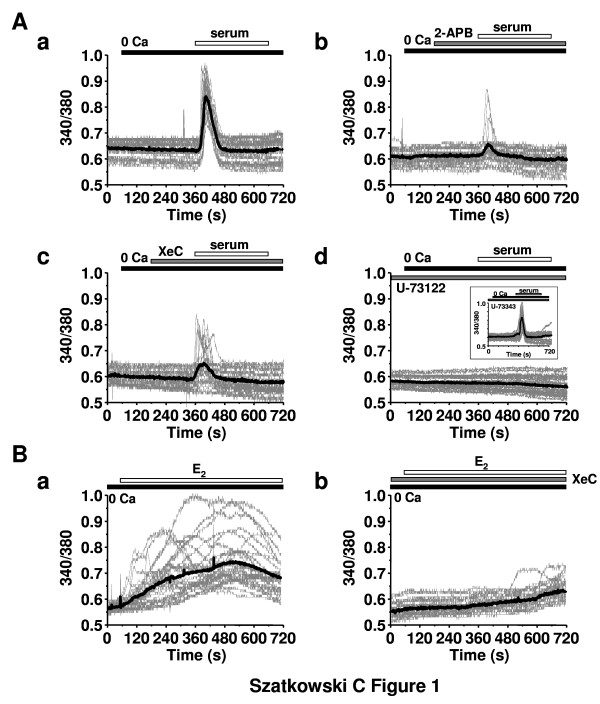
Serum triggers an intracellular Ca2+ signal. (A) The perfusion of a Ca2+-free recording solution containing 5% of serum on Fura-2-loaded MCF-7 cells elicited a strong intracellular Ca2+ signal (a). This signal was due to release from IP3-sensitive Ca2+ stores as it was sensitive to previous application of 2-APB (75 μM, b) or XeC (25 μM, c). Furthermore, U-73122 (20 μM) prevented the effect of serum on intracellular Ca2+ release (d) whereas the inactive analogue U-73343 (20 μM) was ineffective (d, inset). (B) E2 (10 nM) triggered intracellular Ca2+ elevations in MCF-7 cells perfused with a Ca2+-free medium (a); these Ca2+ elevations were inhibited by XeC (25 μM, b). In each panel, the results show the typical traces of 27 to 35 cells, always represented at the same scale; each time, also the mean signal is represented (thick black line).